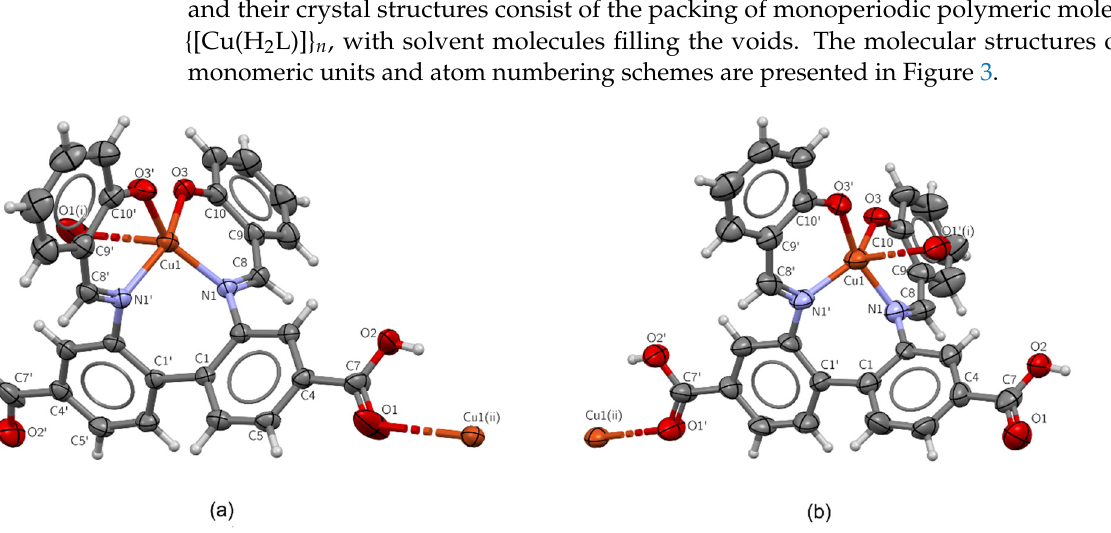
Figure 3. Molecular structures of monomeric units with the atom numbering scheme. ( a ) {[ Cu(H 2 L)]· x MeOH} n ( 1 ); ( b ) {[Cu(H 2 L)]·DMF} n ( 2 ). DMF molecules in 2 are omitted for the sake of clarity.